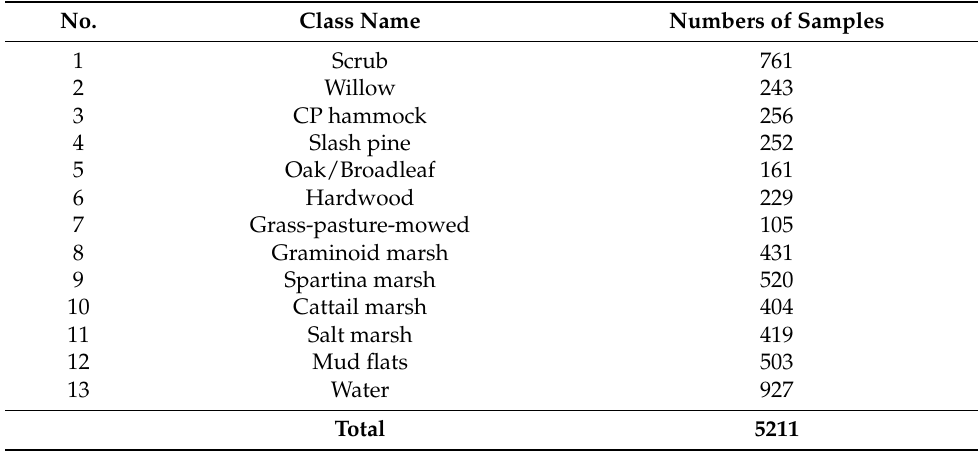
Table 2. Land cover class information for the KSC dataset.